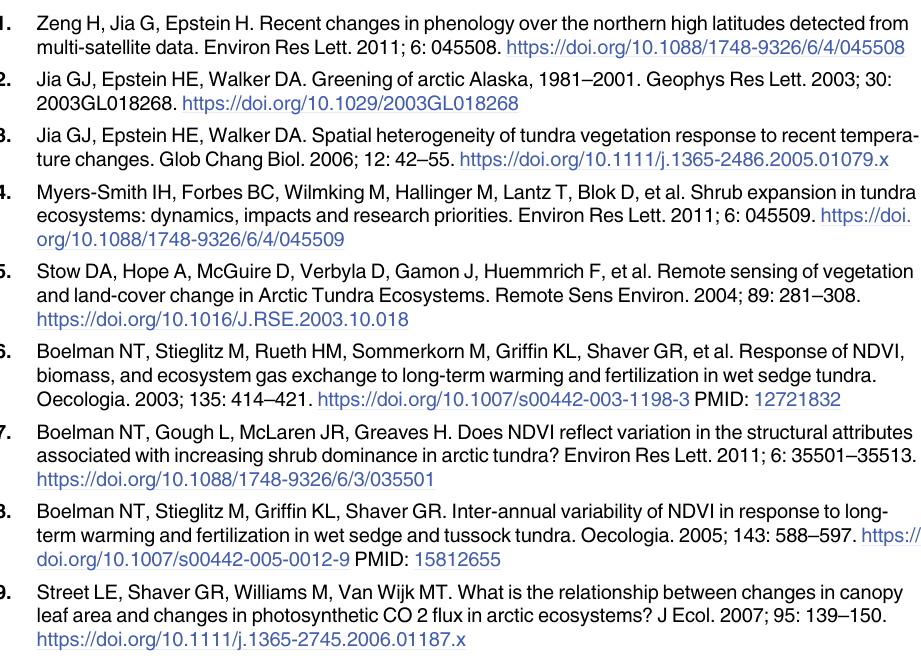
S5 Fig. Correlation matrices displaying strength and direction of correlation for cover propor- tions among the different species present in top cover (A) and repeated cover (B). An “X” rep- resents a statistically significant correlation at P < 0.05